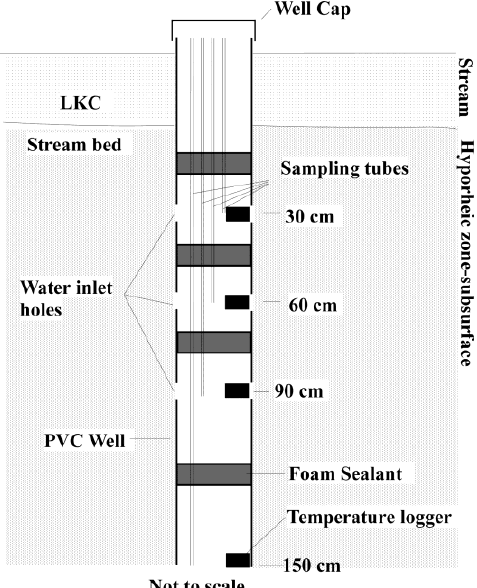
Figure 2. Diagram of multi-level samplers installed in the streambed. The sampler is divided at four depths, with tubing confined to each sampling depth.